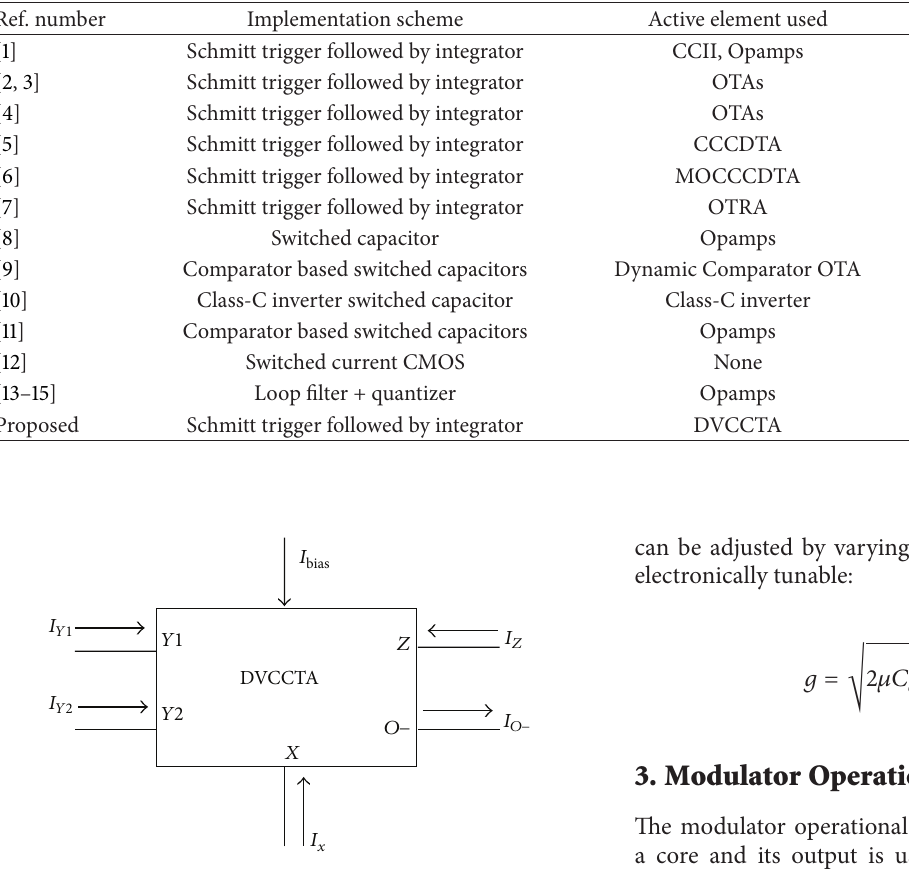
Figure 1: Symbol of proposed